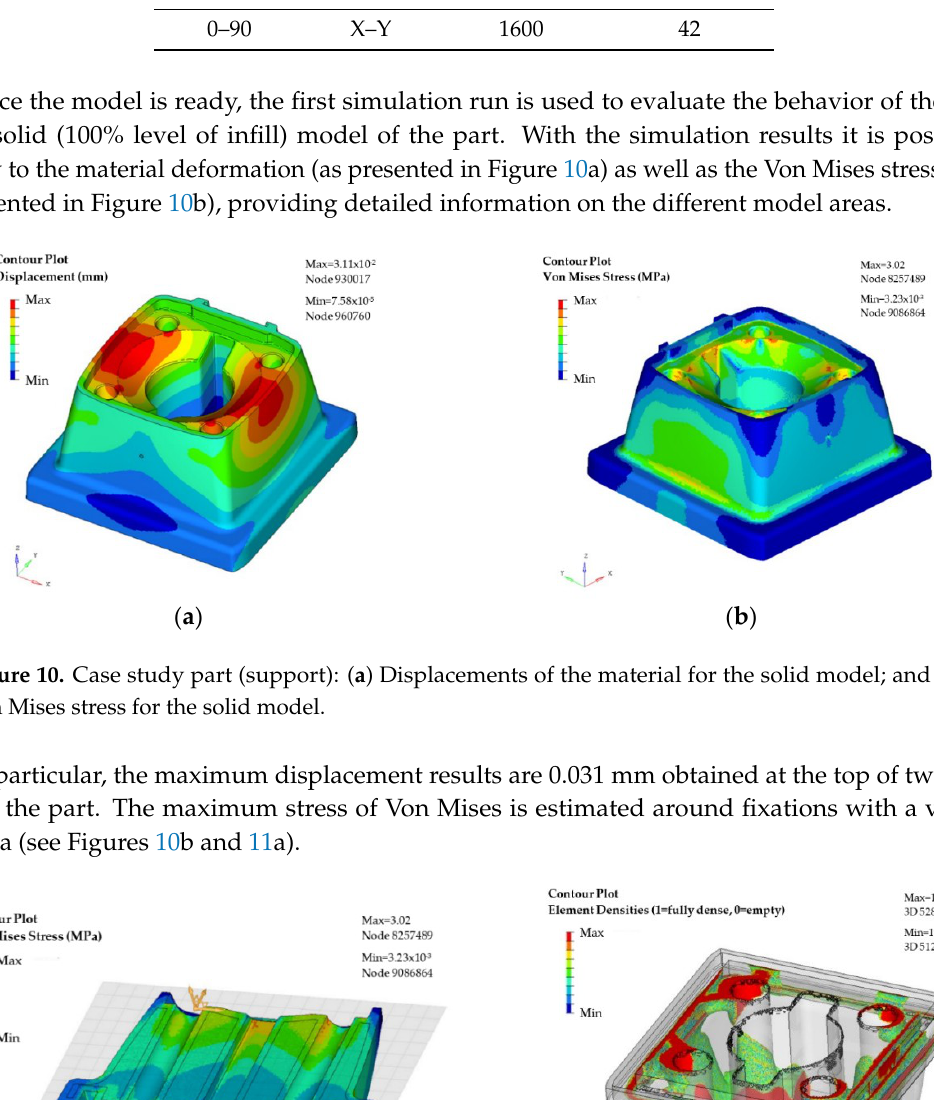
Figure 11. Case study part (support): ( a ) Von Mises stress focused on fixations; and ( b ) results of topological optimization.